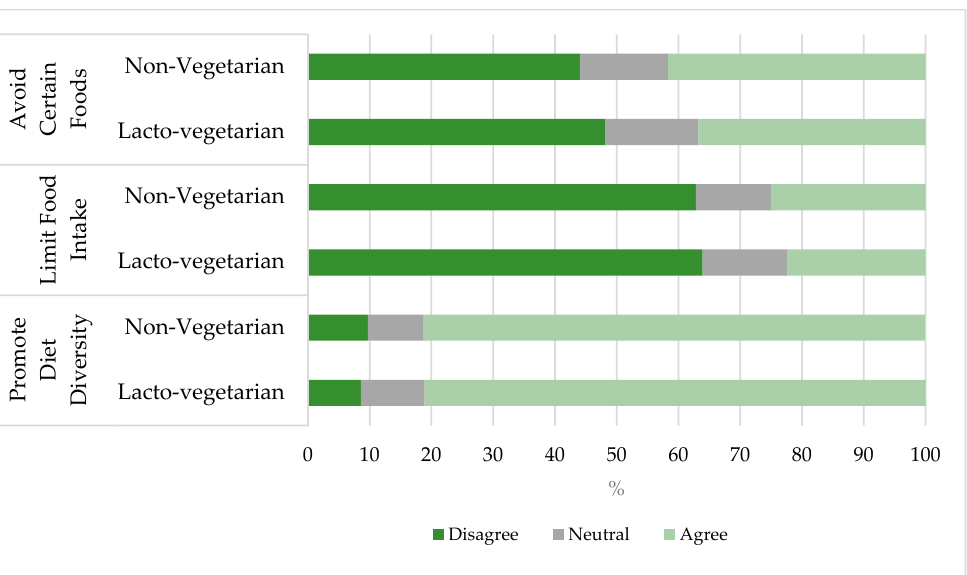
Figure 1. Social norms about diet and nutrition during pregnancy. Participants were asked the